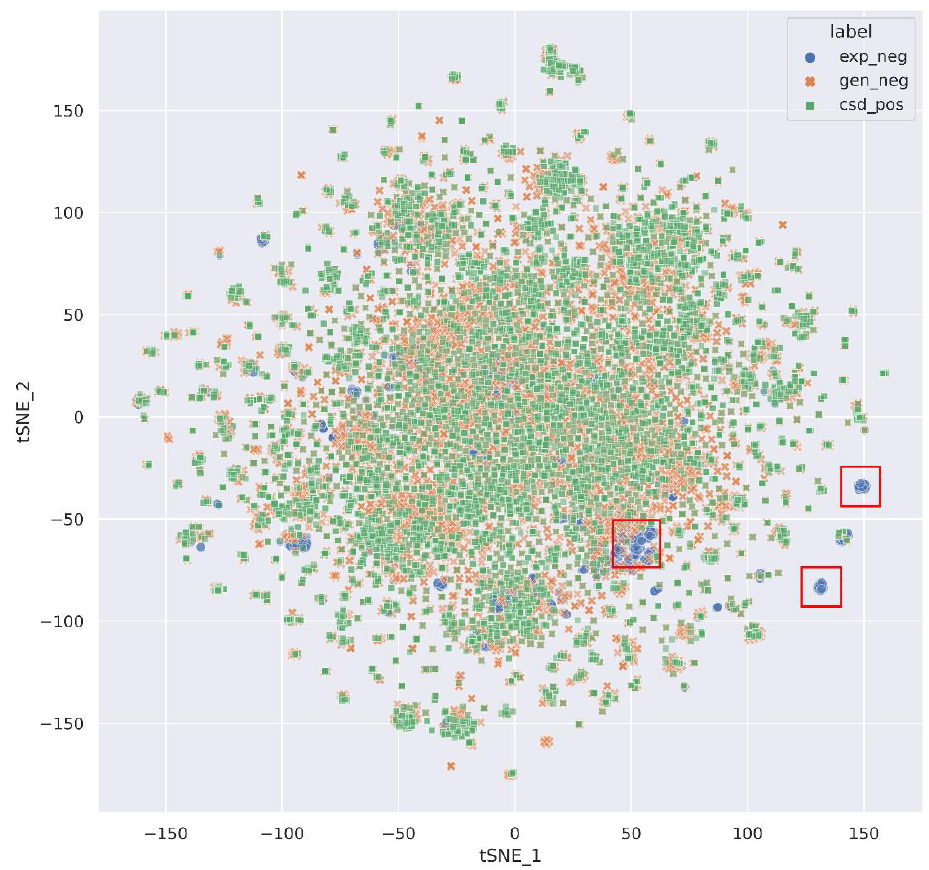
Figure 4. Chemical space distribution of exp_neg (blue), gen_neg (orange), and csd_pos (green) dataset by t-SNE method using ECFP fingerprint. The red box mainly highlights blue points that do not overlap with orange and green points.